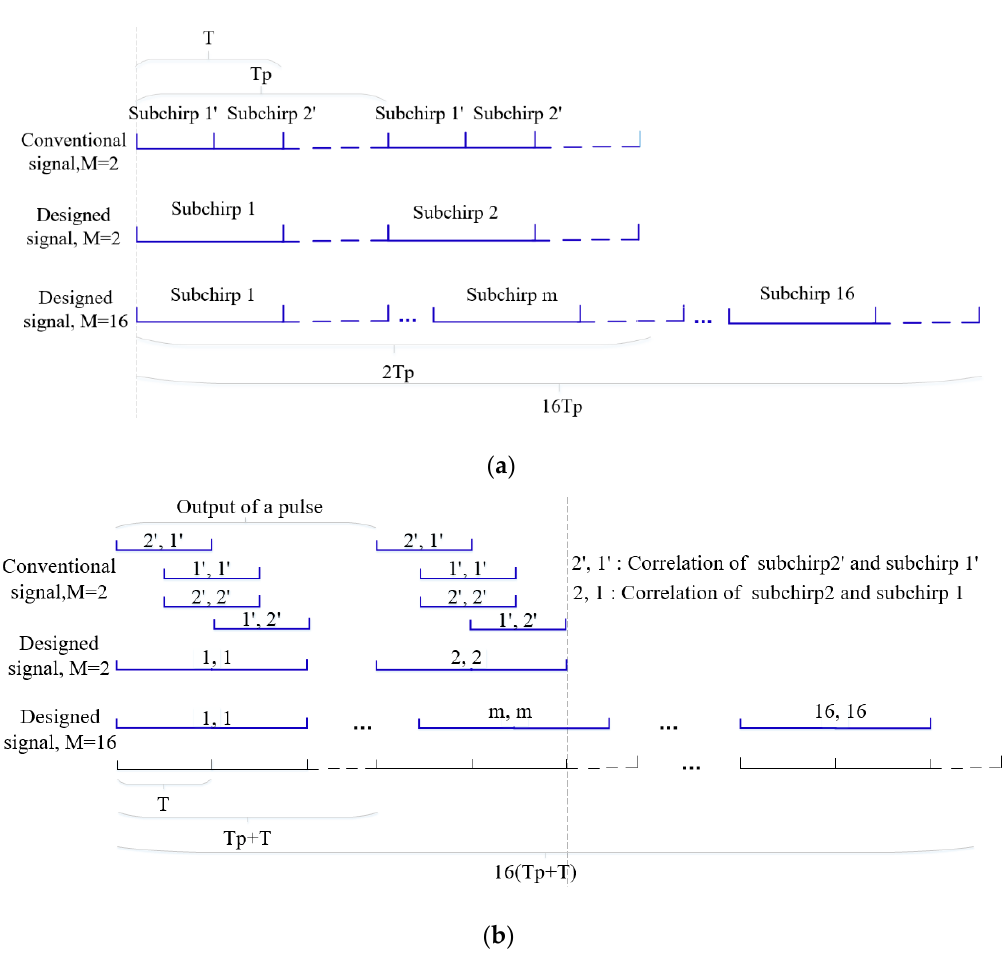
Figure 5. The transmitting and processing structure of designed signals: ( a ) Transmitting structures of two signals; ( b ) matched filtering output structures of two signals.